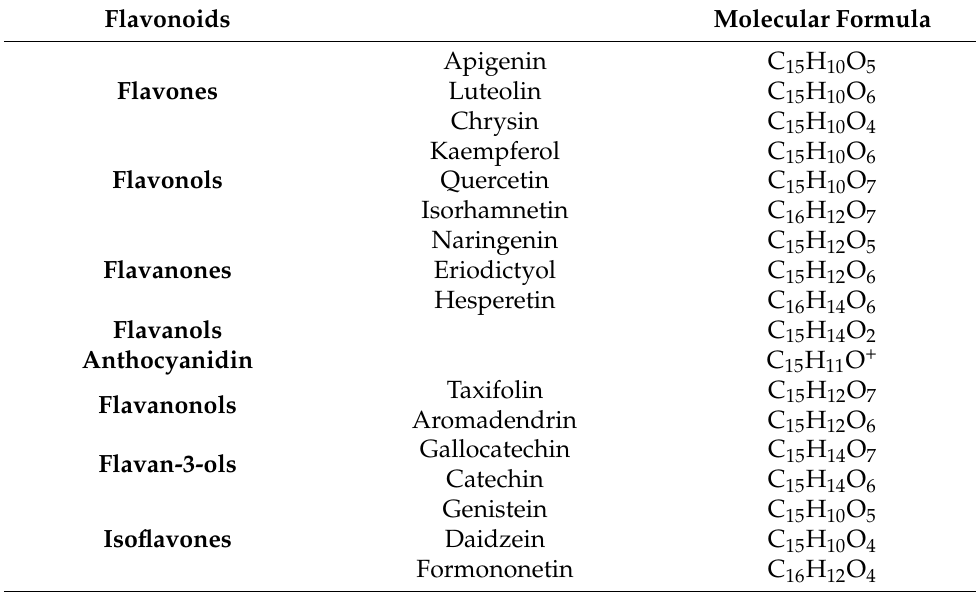
Table 3. Generic structure of major classes of